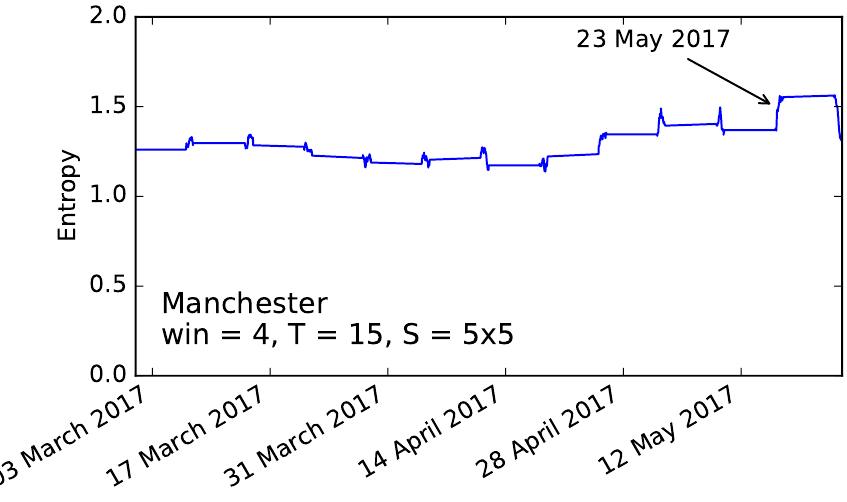
Figure 5. Entropy evolution in the Manchester data set with the selected